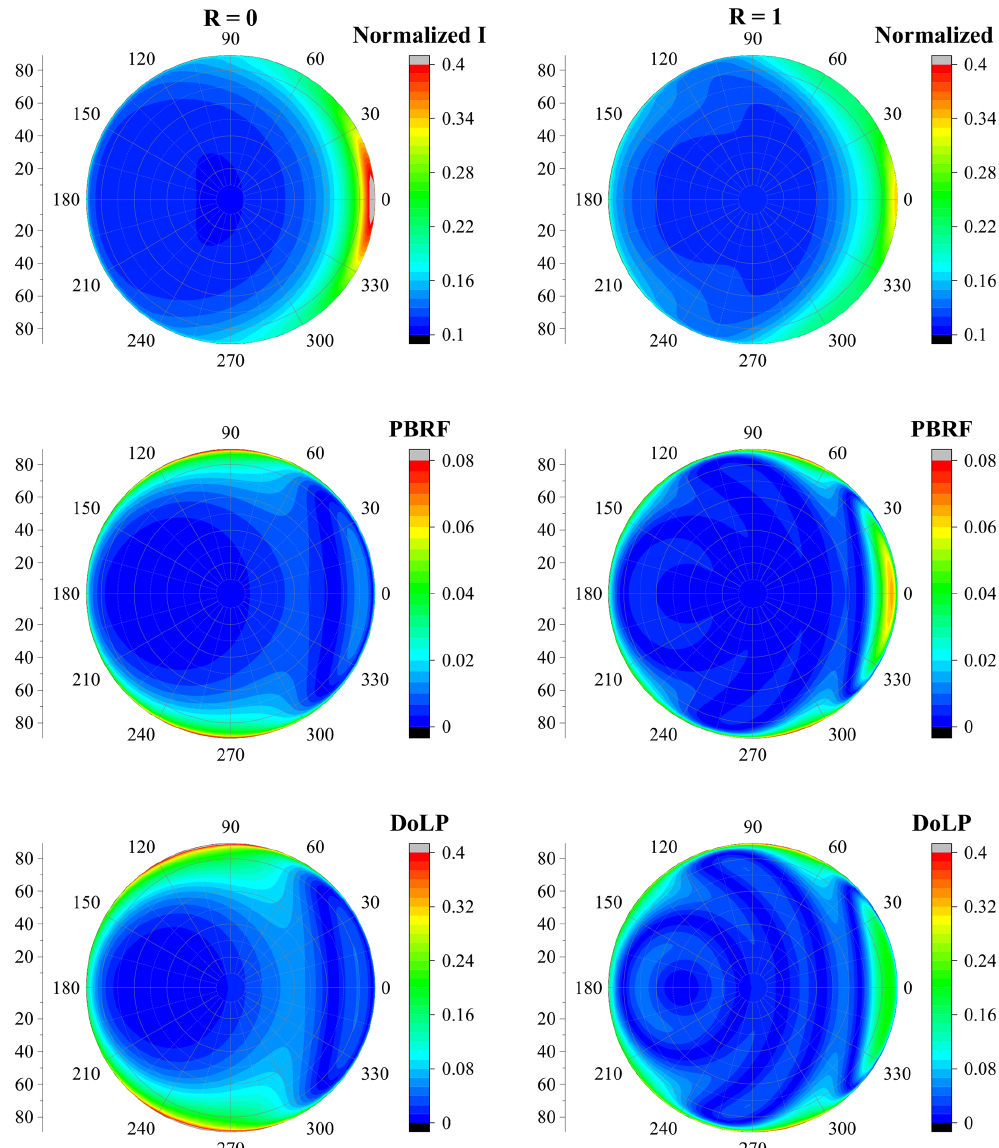
Figure 12. The polarimetric characteristics of dust with irregular shapes, where the aspect ratio is 2 : 1, d p = 0 . 8µm, f = 0 . 8.